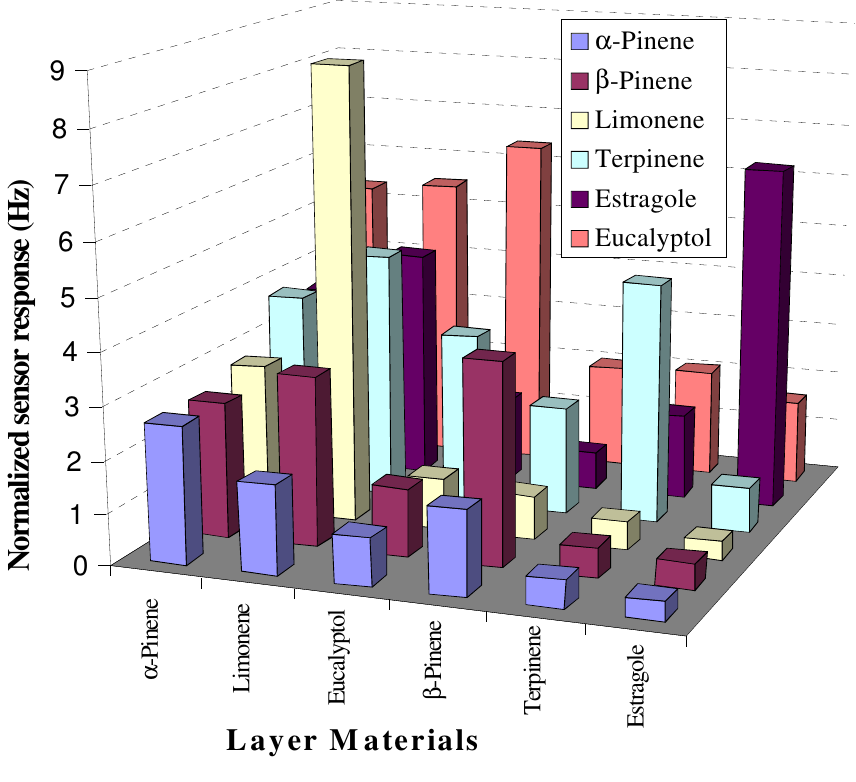
Figure 3. Selectivity profile of e-nose at 50